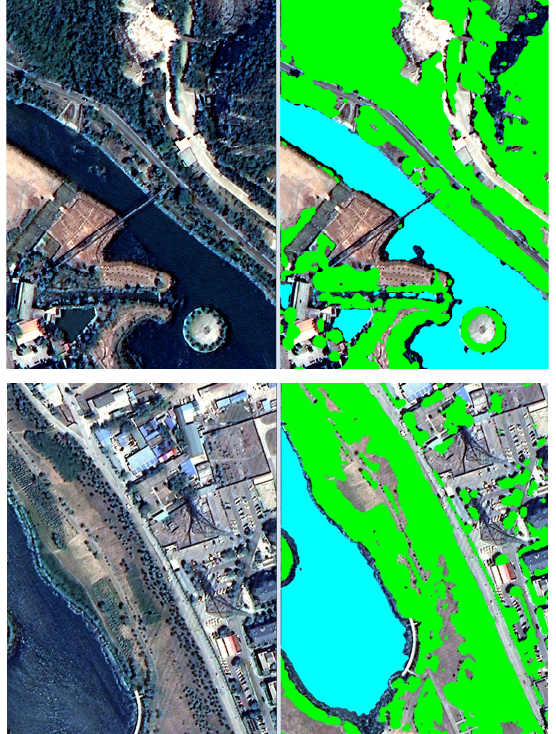
Figure 7. An example of automated recognition of vegetation and water objects for two test sites on the images of the Mentougou city from the SuperView-1A satellite for May 5, 2017 with the same settings of binarization thresholds The overall classification accuracy is from 85% to 92% with the kappa coefficient ranging from 0.81 to 0.86.